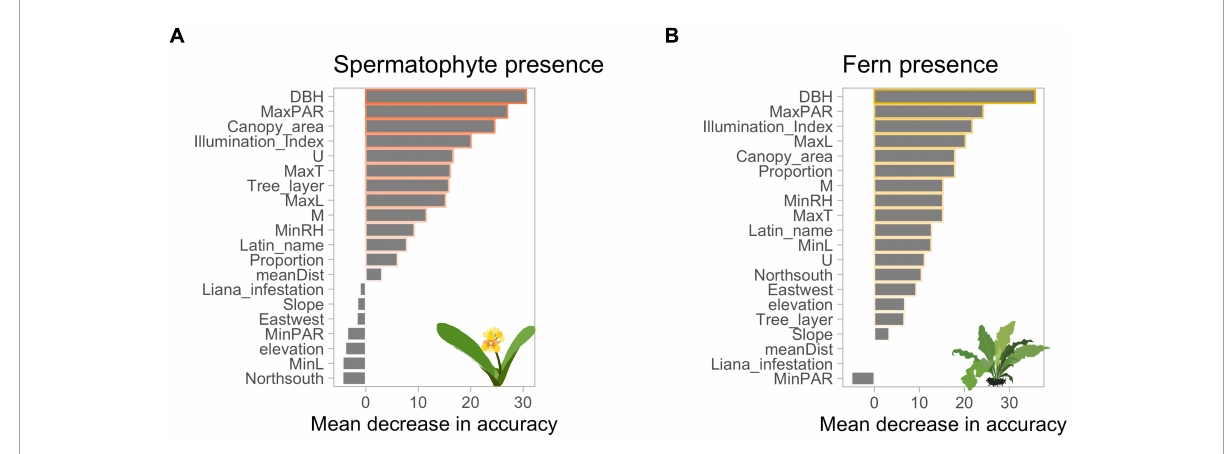
FIGURE2 Importance (as measured by the mean decrease in accuracy) of the factors accounting for the probability that a given tree hosts epiphytes in classification random forest in a lowland tropical rainforest (Xishuangbanna, Yunnan, SW China). (A) Epiphytic spermatophytes; (B) epiphytic ferns. See Table 1 for